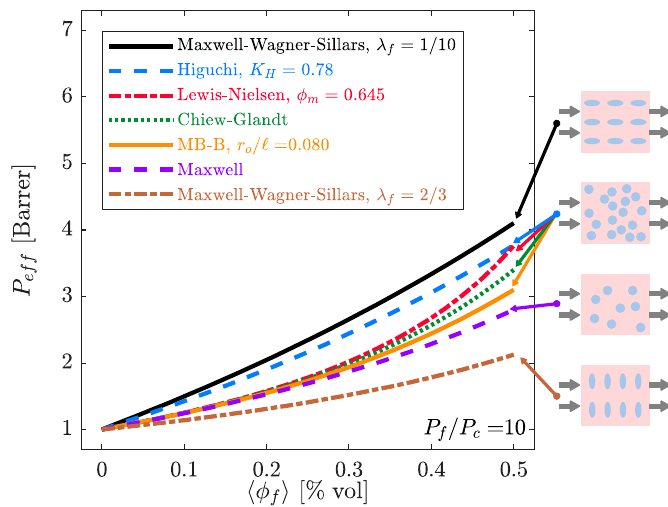
Figure 5. Comparison of permeability profiles based on the ideal models of Table 2 with α fc = P f / P c = 10, depicting the composite structure considered in each model.